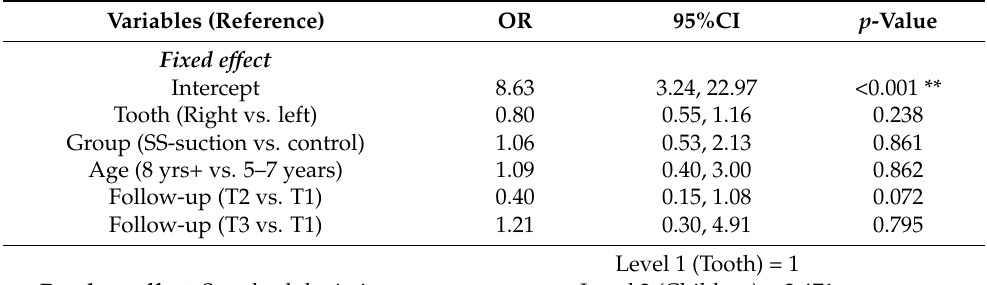
Table 5. Effect of SS-suction on occlusal caries controlling for confounding factors: result from multilevel logistic regression (FU